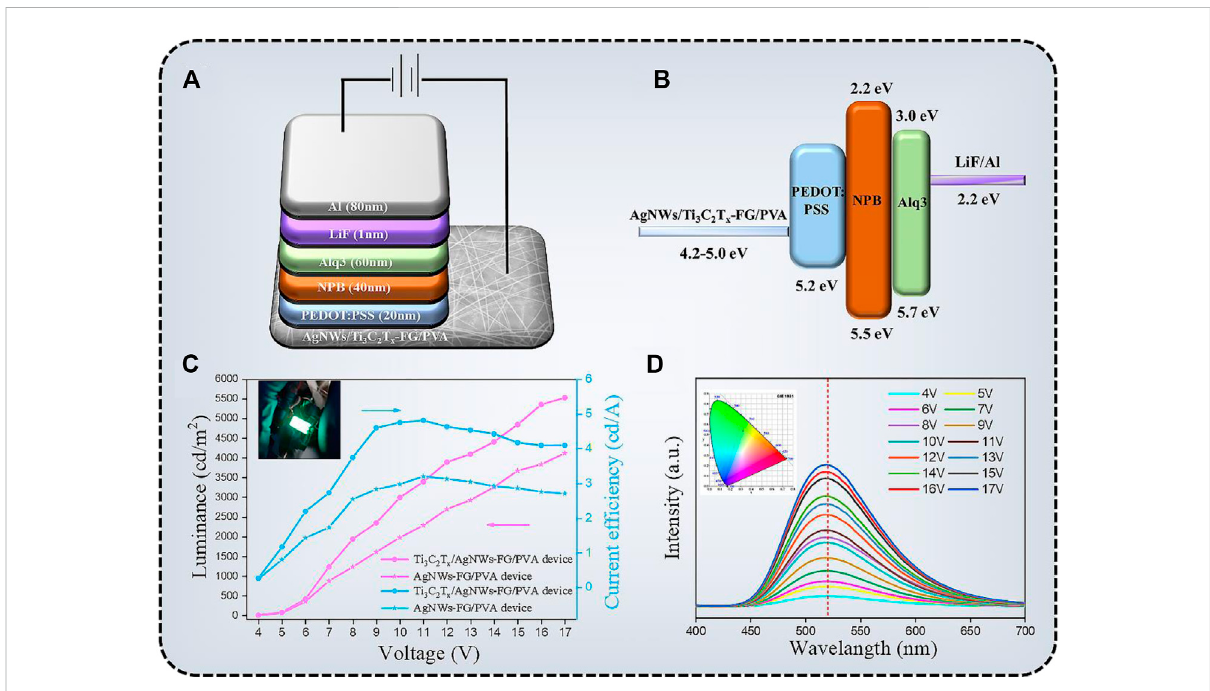
FIGURE 9 (A) The structure of green OLEDs on the AgNWs/Ti 3 C 2 T x -FG/PVA anode. (B) The energy diagram of the OLED device. (C) Voltage-Luminance curve and Voltage-Current ef fi ciency curve for the OLED device (inset: the image of OLED device); (D) electroluminescence (EL) spectra of the OLEDs (inset: CIE color